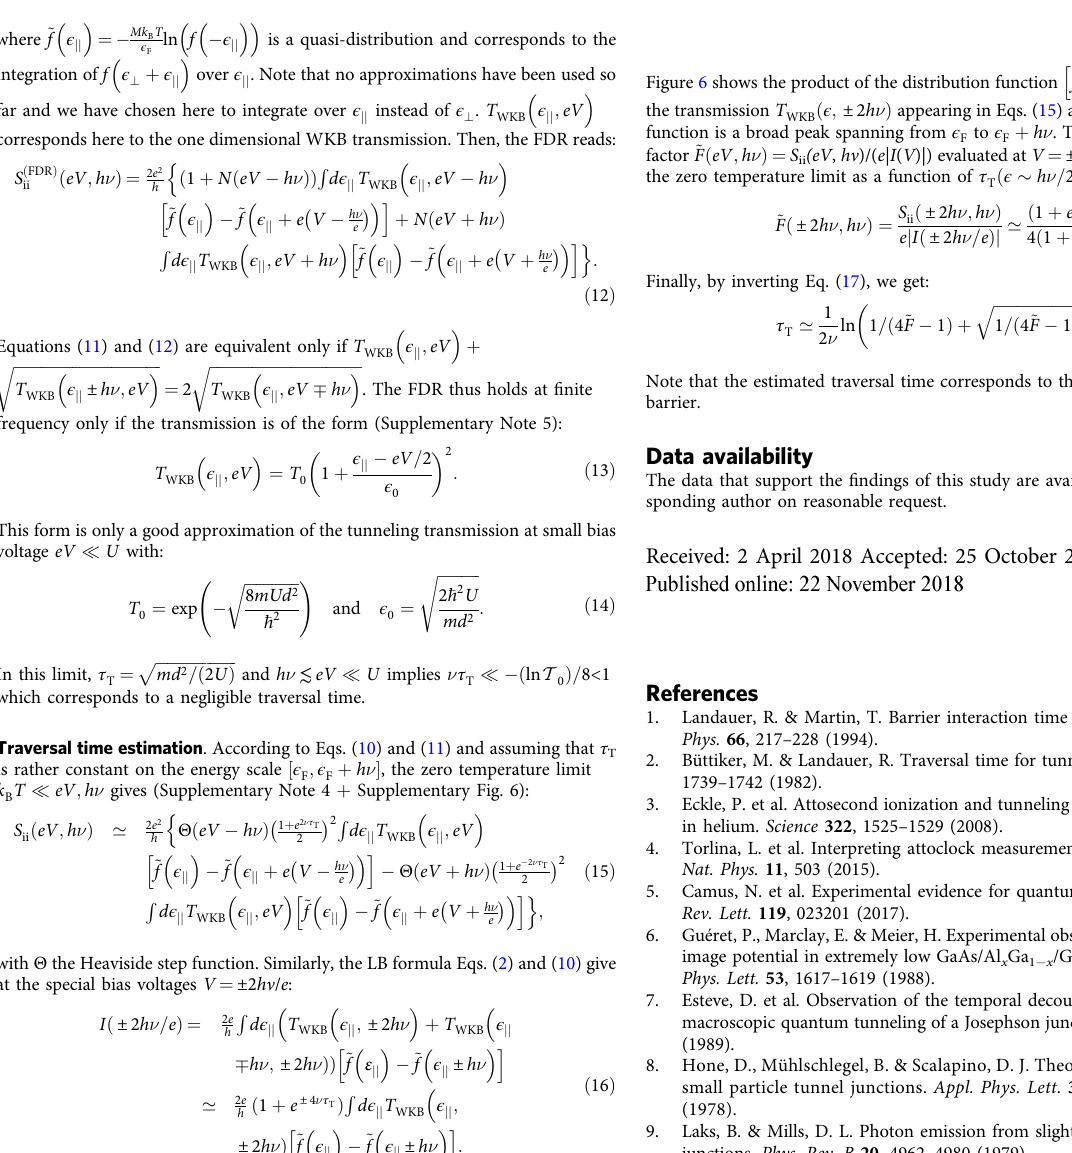
ffiffiffiffiffiffiffiffiffiffiffiffiffiffiffiffiffiffiffiffi ffiffiffiffiffiffiffiffiffiffiffiffiffiffiffiffiffiffiffiffiffiffiffiffiffiffi T WKB ϵ jj ; eV ð þ T WKB ϵ jj þ h ν ; eV ð Fig. 6 Traversal time estimation. The dashed black curve is the difference between the distribution functions appearing in Eqs. (15) and (16) for 1 eV. The dash-dotted red curve represents the transmission T WKB . The product of these two functions is pictured in blue (solid line): this broad-peaked curve allows us to evaluate the generalized Fano factor, and thus the traversal time in the zero